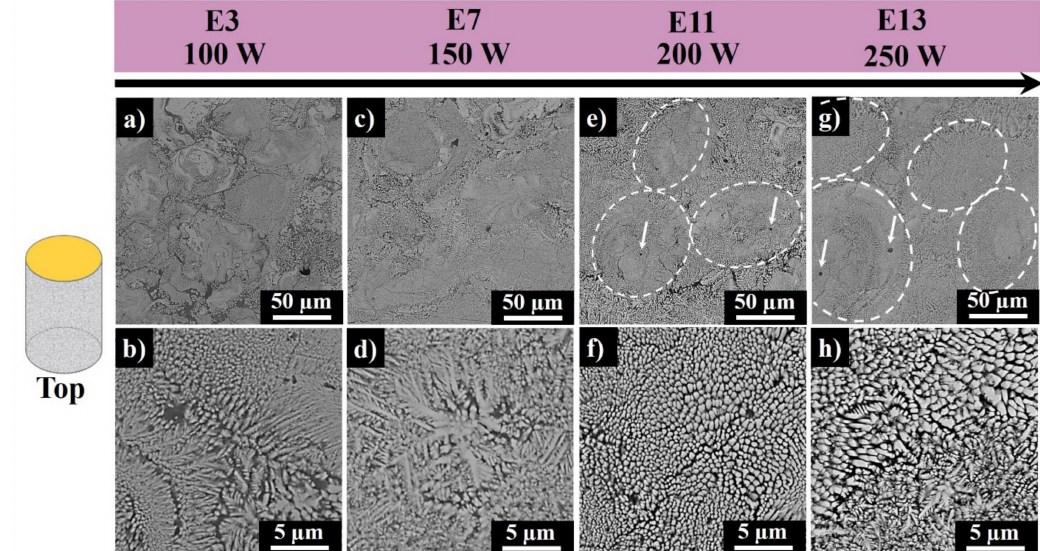
Figure 11. Top surface SEM images of sample E3 ( a , b ), E7 ( c , d ), E11 ( e , f ), and E13 ( g , h ) produced at 100 W, 150 W, 200 W, and 250 W laser powers, respectively, and at 700 mm · s − 1 scanning speed (dashed ovals represent melt pool cores, and the white arrow points to the precipitates of Al–Si-rich phase).